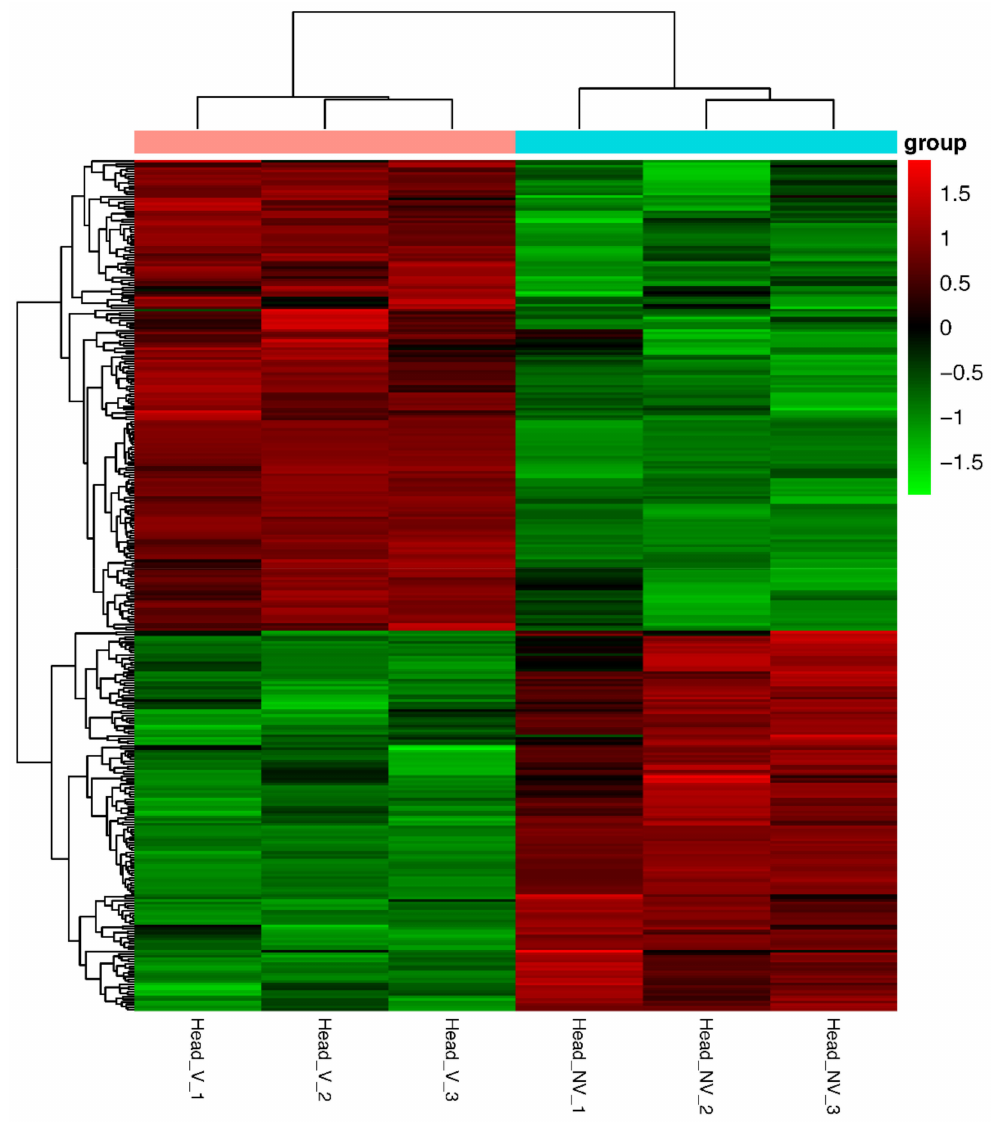
Figure 4. Heat map of differentially expressed genes (DEGs) in viruliferous and non-viruliferous SBPH heads. X-axis represents the names of the samples; Y-axis represents the normalized value of the differential gene FPKM. Red represents higher expression, black represents medium expression, and green represents low